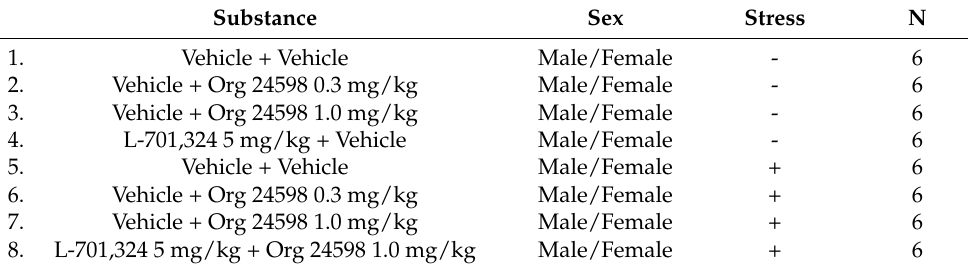
Table 1. Experimental groups used in the reversal learning of the Barnes maze